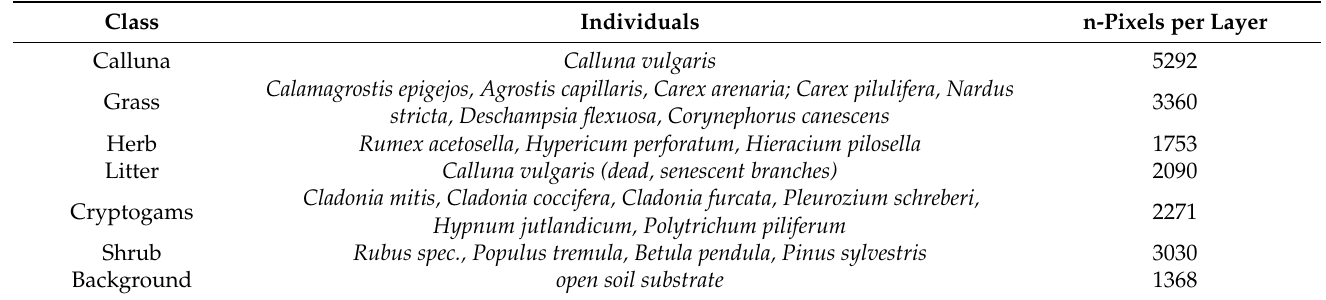
Table 3. Aggregated classes used for after-mowing classification; related individual composition of field sample idents and number of extracted pixels using n = 178 polygons for each layer in UAV drone